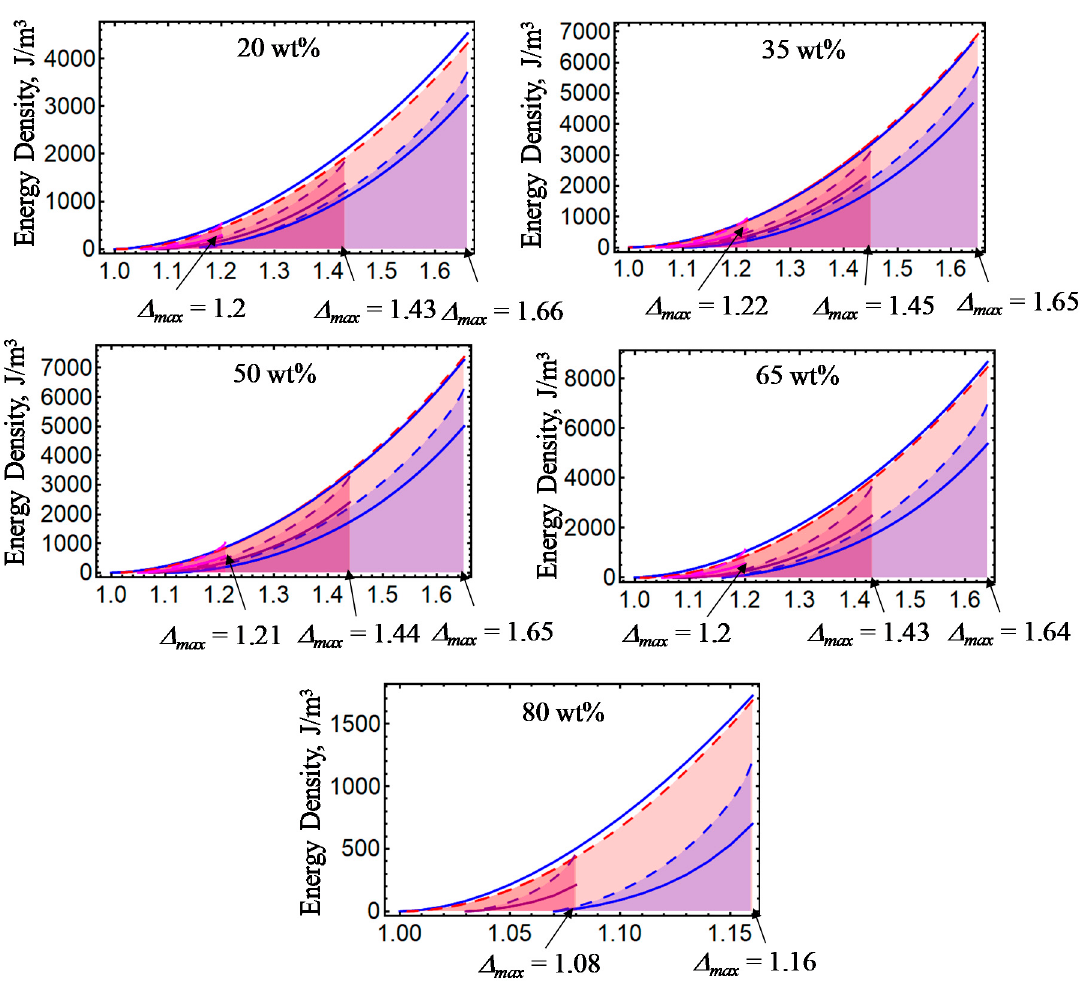
Figure 2. Energy dissipation curves for isotropic magnetorheological material samples subjected to loading and unloading cycles with B = 0 mT. Notice that for increasing wt% of CIPs, the dissipation area broadens, which is an indication of the damage experienced in the material during cyclic loading.